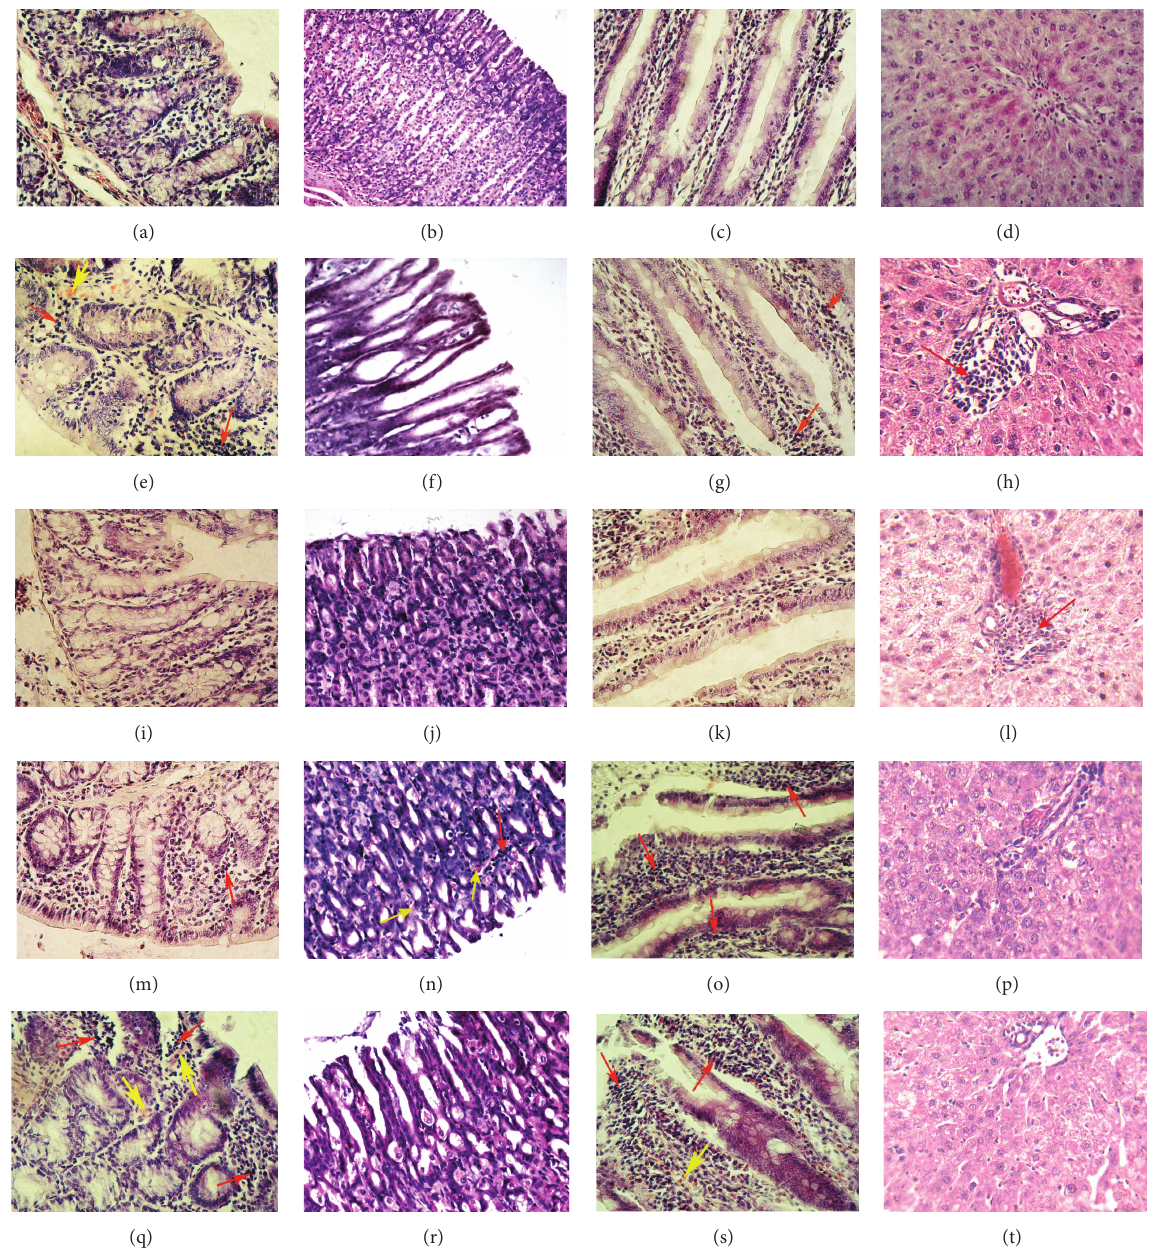
Figure 2: Microphotographs of rat colon ((a), (e), (i), (m), and (q)), gastric ((b), (f), (j), (n), and (r)) and jejunal ((c), (g), (k), (o), and (s)) mucosa, and liver periportal zone ((d), (h), (l), (p), and (t)); hematoxylin-eosin-orange stain; magnification 400x. Experimental groups: control: (a), (b), (c), and (d); DMH: (e), (f), (g), and (h); DMH + D 1 7 weeks : (i), (j), (k), and (l); DMH + D 1 27 weeks : (m), (n), (o), and (p); DMH + 5FU: (q), (r), (s), and (t). Inflammatory features in groups DMH ((e), (g), and (h)), DMH + D 1 7 weeks (l), DMH + D 1 27 weeks ((m), (n), and (o)), and DMH + 5FU ((q) and (s)) are manifested by lymphatic and histiocytic cells infiltration, marked by red arrows, and blood capillary dilations, marked by yellow arrows. Damage of surface epithelium appeared in groups DMH ((f) and (g)) and DMH + 5FU ((q), (r), and (s)) and appeared less in DMH + D 1 27 weeks